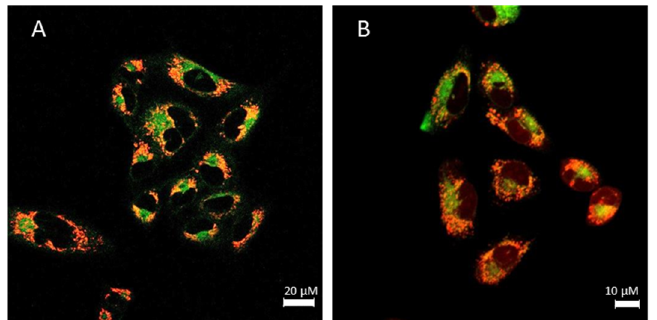
Figure 9. Superimposition images in A549 cells of complexes 2 ( A ) and 4 ( B ) incubated 2 h and stained with MitoTracker Red (MTR). stained with MitoTracker Red